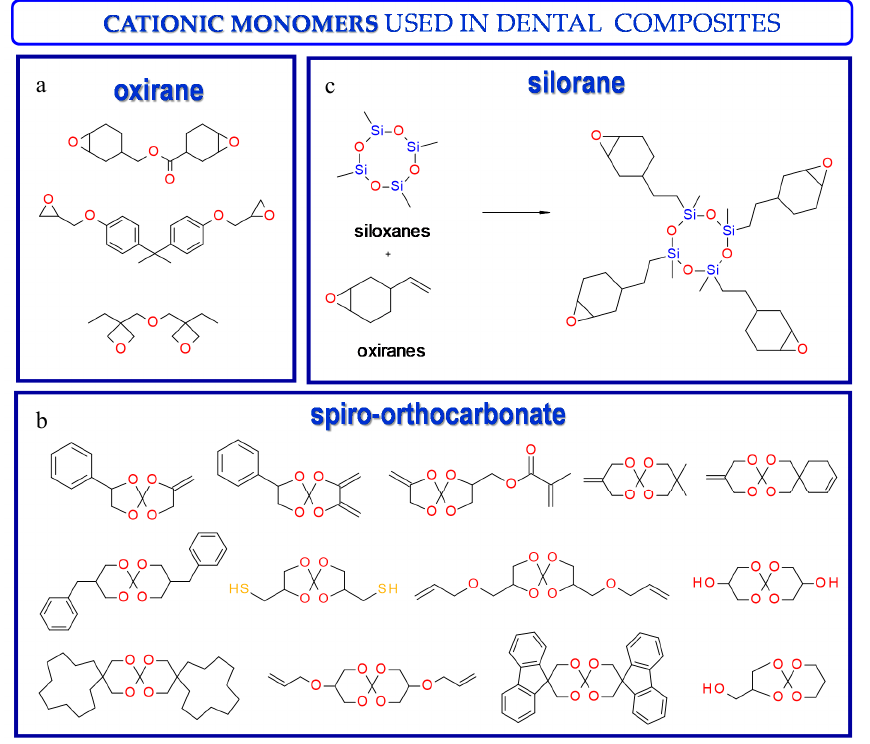
Figure 4. Examples of monomers used in cationic photopolymerization ( a ) oxirane, ( b ) spiro- Figure 4. Examplesofmonomersusedincationicphotopolymerization( a )oxirane,( b )spiro-orthocarbonate, ( c ) silorane: a merger of siloxanes and